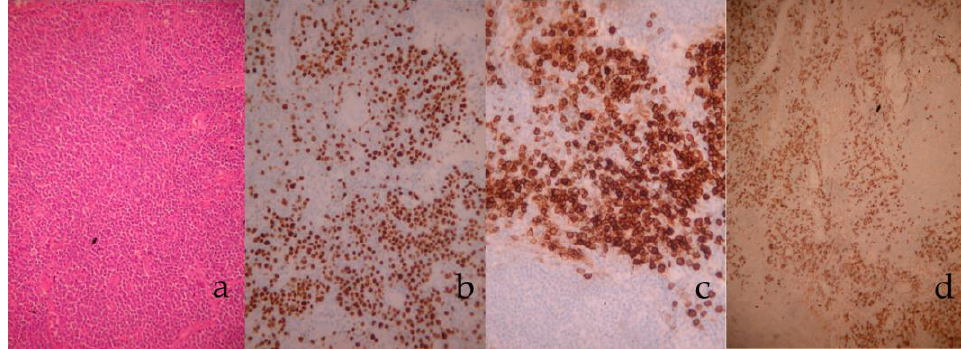
Figure 3. Histopathological and immunohistochemistry images: extensive plasma cell-like infiltration H&E × 100 ( a ); positive staining for MUM1 × 100 ( b ) and CD138 × 200 ( c ); κ - light chains × 100 ( d ).